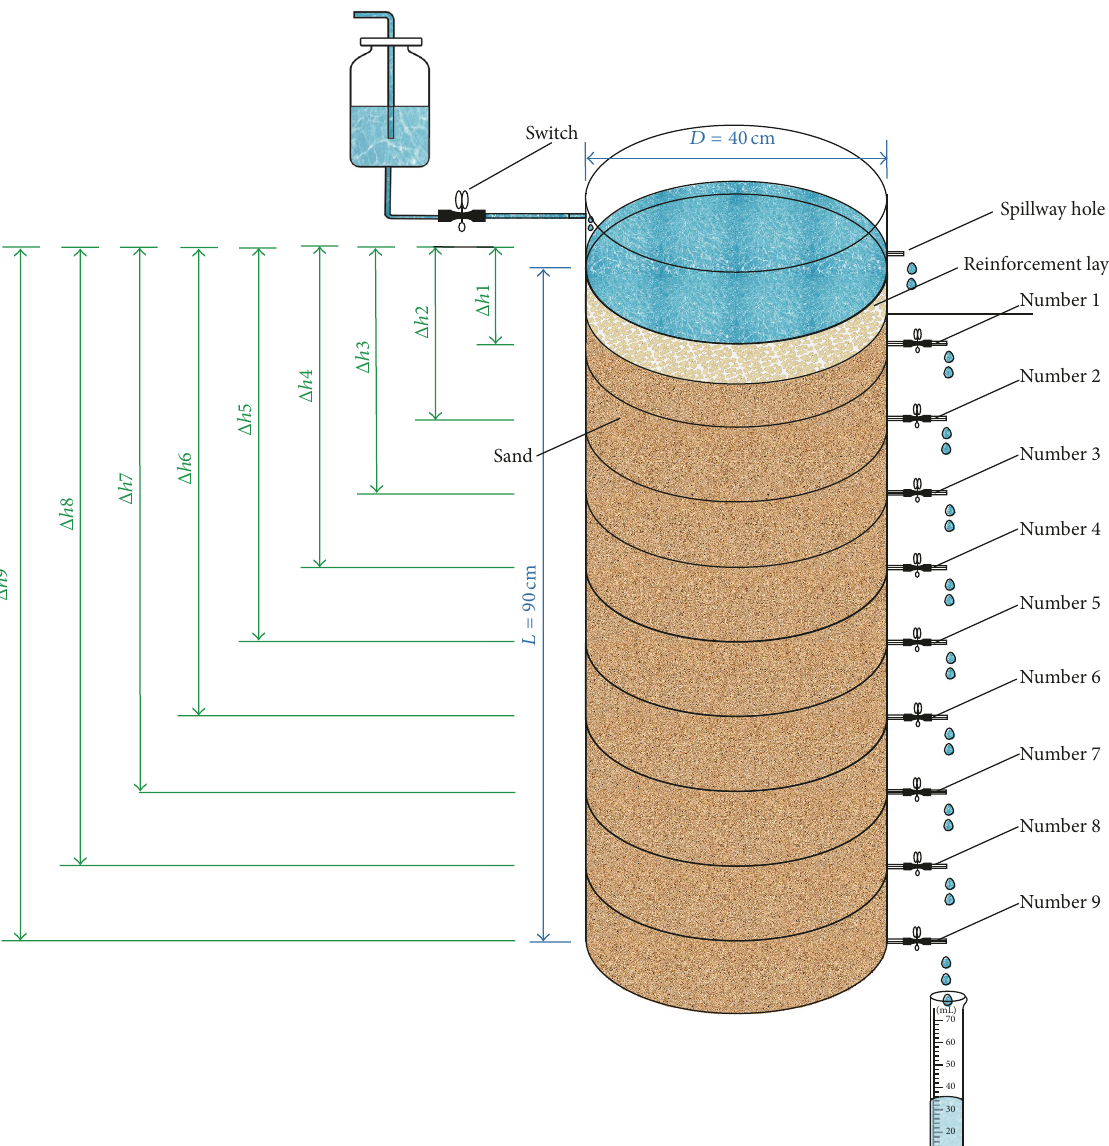
Figure 4: Porous permeameter used in porous permeability